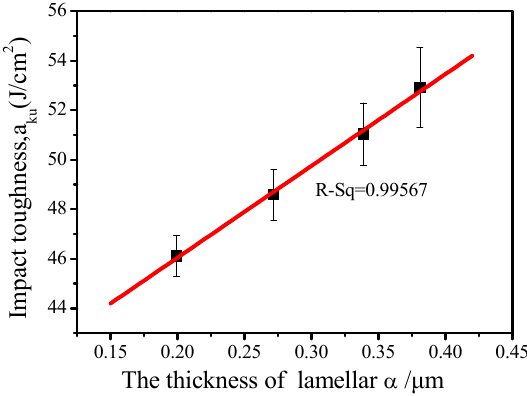
Figure 10. The relation between the impact toughness with thickness of lamellar α at Ti17 alloy.